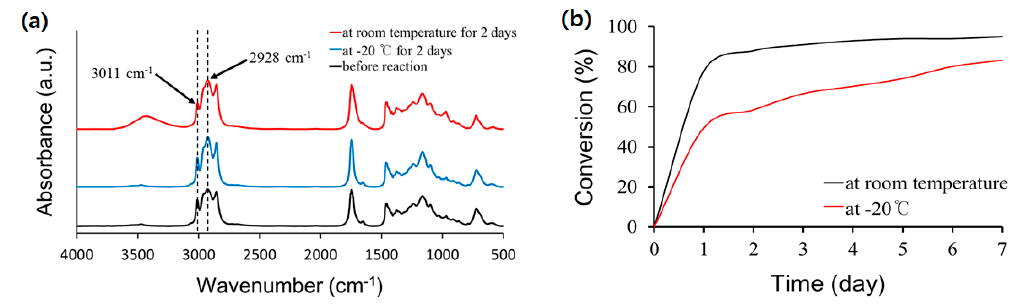
Figure 1. ( a ) FT-IR spectra of linseed oil before and after oxidation at room temperature or at − 20 °C for 2 days; ( b ) Reaction conversion of linseed oil versus time at room temperature or at − 20